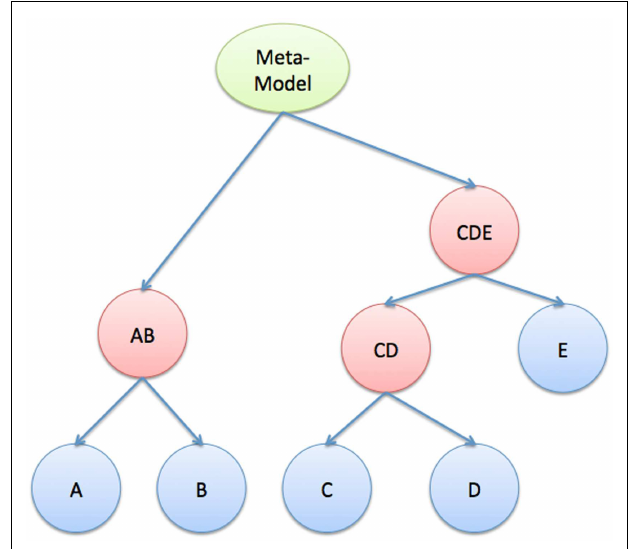
FIGURE 7 | Hierarchical composition .Tree structure that describes the hierarchical relationships between atomic models, the meta-model, and partial-composition